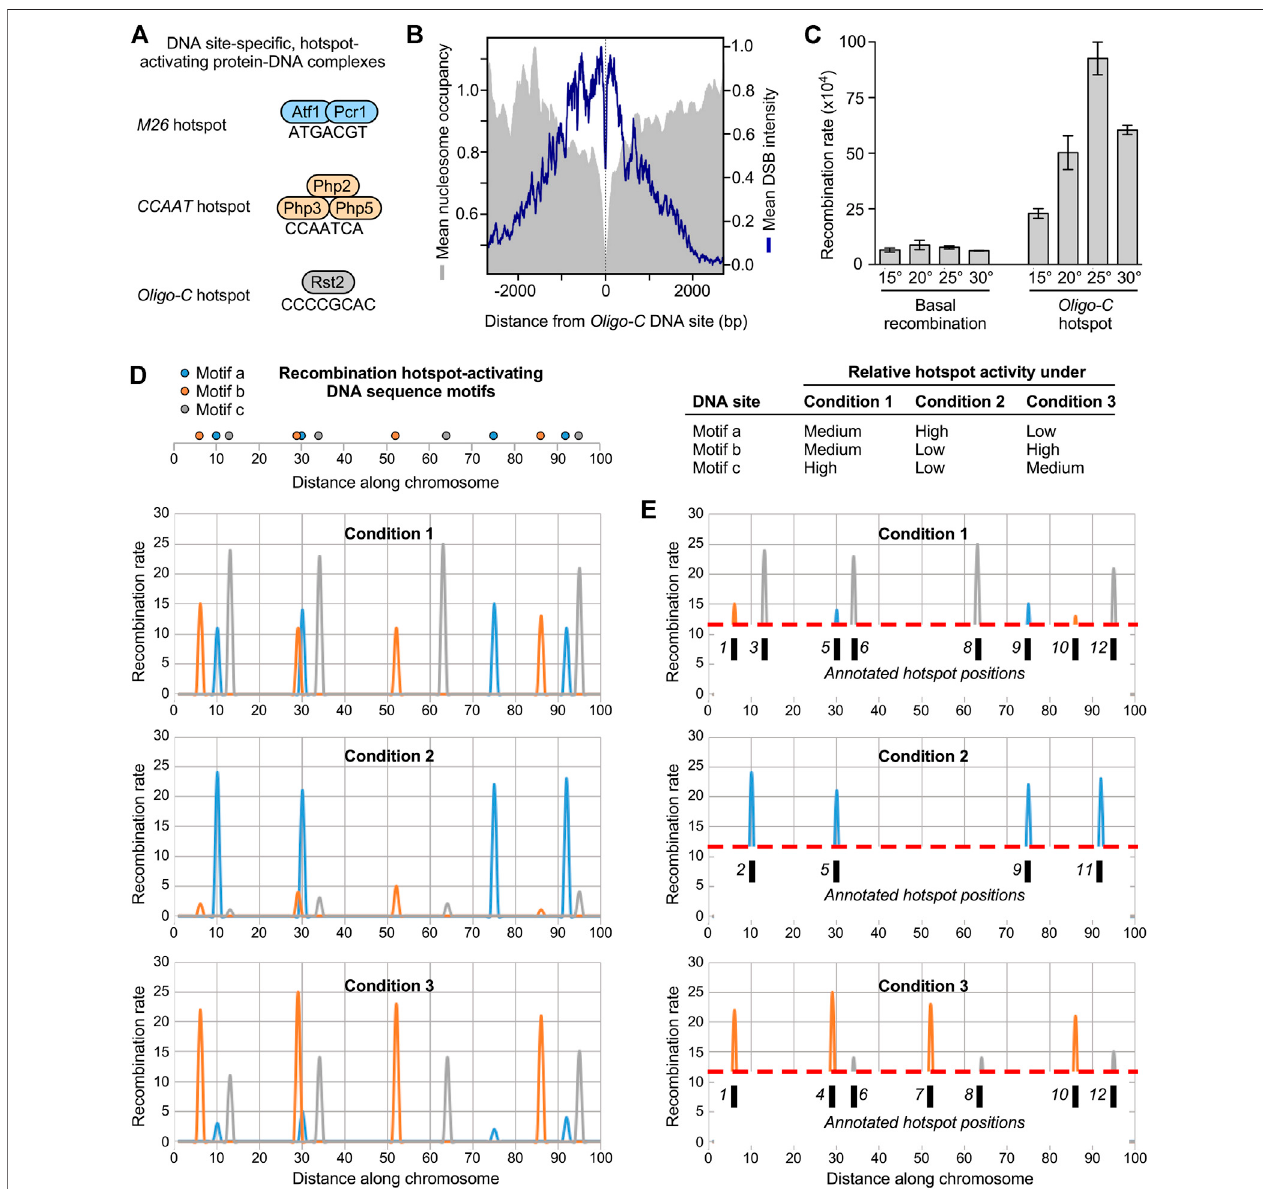
FIGURE 2 | Mechanisms for plasticity in the frequency distribution of meiotic recombination (A) Examples of DNA site-speci fi c protein-DNA complexes ( cis- acting regulatorymodules)thatactivaterecombinationhotspots (B) The cis- actingregulatorymodulespromotecatalysisofDSBsbythebasalrecombinationmachinery.Inthis example, Oligo-C DNAsitesinthegenomewereidenti fi ed,orientedandaligned;plotshowsaveragedistributionofDSBs( blue )andnucleosomes( grey )aroundtheDNA site (C) Hotspots function as rheostats that variably modulate recombination rates in response to extracellular and intracellular cues. Example shows rates of recombination for the Oligo-C hotspot and for a basal recombination control at different temperatures (D) Model for plasticity in the recombination landscape. Each hotspot DNA site promotes recombination in its vicinity. Each different class of hotspots is independently controlled in response to changing conditions. Their net contributions under different conditions dramatically alter the recombination landscape (E) It is standard practice in the fi eld to apply frequency thresholds (illustrated by dashedredlines )toannotatehotspotpositions( numberedticmarks ).Thiscangivethefalseimpressionthatthepositionsofhotspots “ move ” fromconditiontocondition or population to population (compare E to